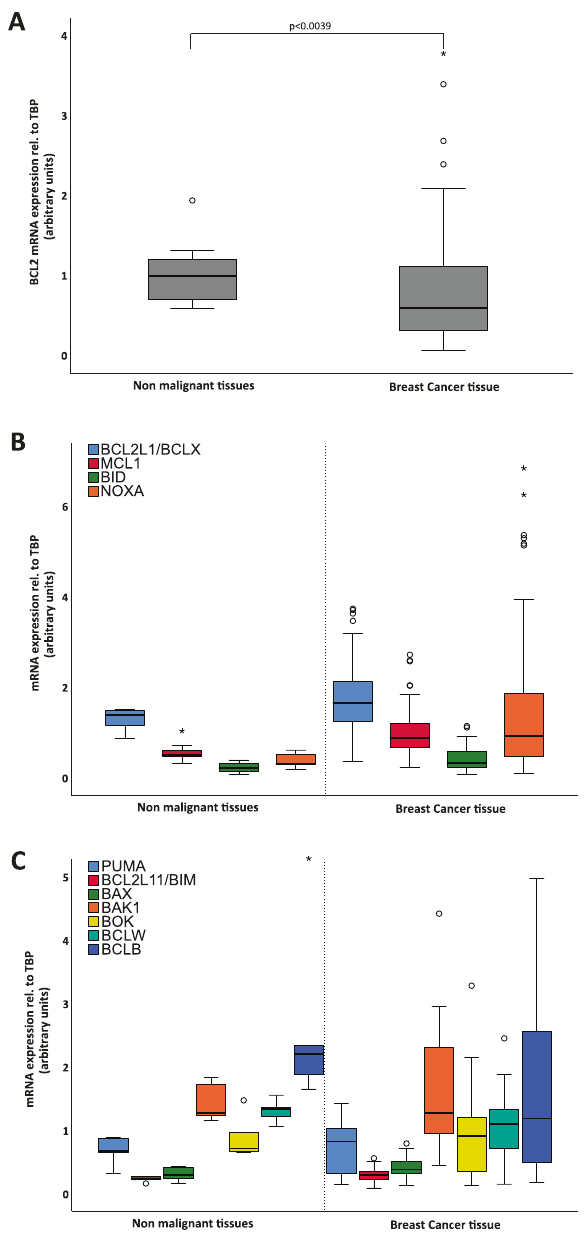
Fig. 1 mRNA expression analysis of BCL2 family members in 10 non neoplastic and 92 neoplastic breast tissues. mRNA expression of A BCL2 ( p = 0.039), B BCLX ( p = 0.035), MCL1 ( p = 0.001), BID ( p = 0.020) and NOXA ( p = 0.002) and C PUMA, BIM, BAX, BAK, BOK, BCLW and BCLB. Extreme values are marked with asterisks, outliers with